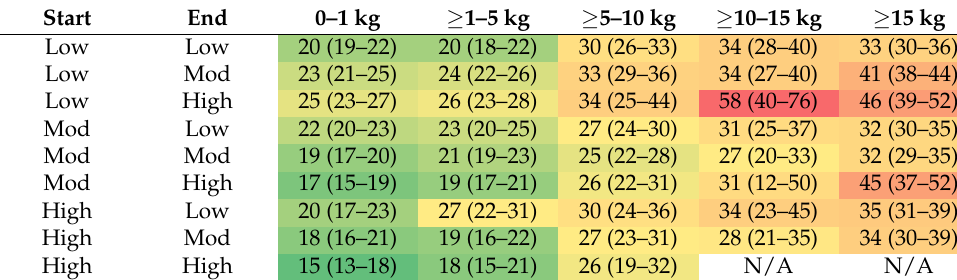
Muscular workload estimates color graded from green to red, with lower estimates marked as nuances of green and higher estimates marked as nuances of red. The analyses were mutually controlled for each predictive variable, participant age, sex, and muscle. N/A = estimate not available due to low number of observations, i.e., low statistical